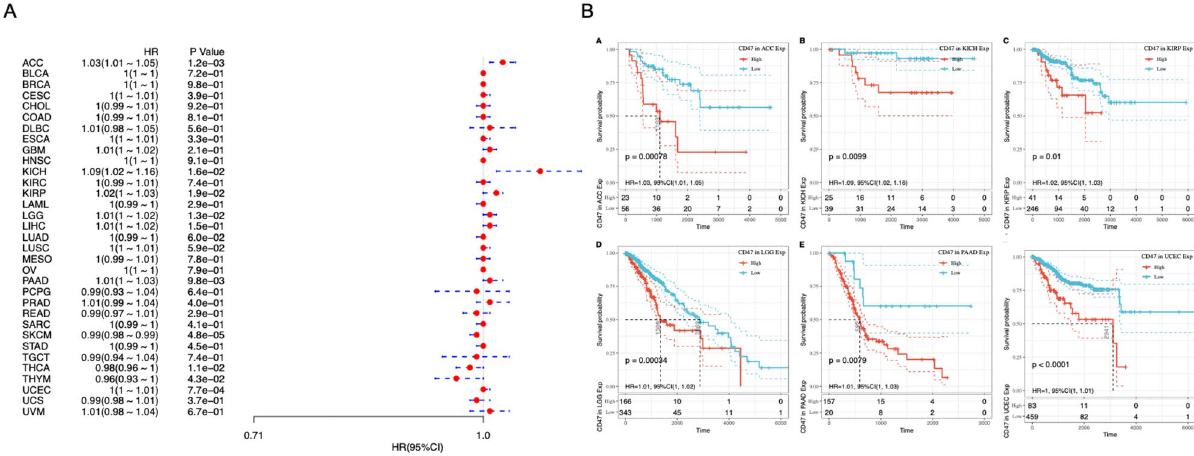
Figure 2. High expression of CD47 was associated with a worse prognosis in cancers. ( A ) Forest plot was performed to analyze CD47 expression on OS in 33 cancer types by Cox regression model. ( B ) Kaplan–Meier analysis demonstrated high expression of CD47 predicted poor prognosis in ACC, KICH, KIRP, LGG, PAAD,